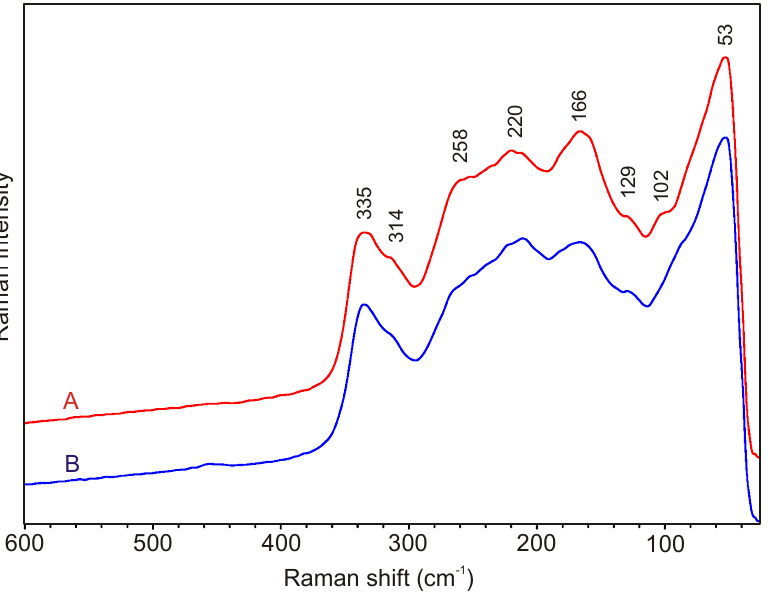
Figure 9. Comparison of Raman spectra of disulfodadsonite from Kľačianka (A) and Ceragiola, Italy (B).